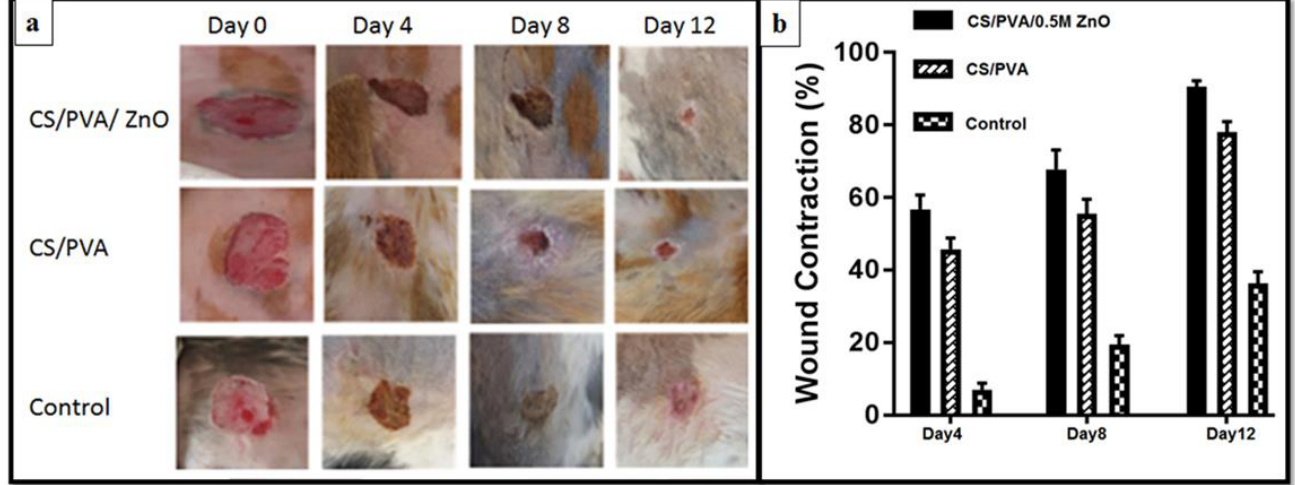
Figure 10. ( a ) The wound healing time of diabetic rabbits treated with control, CS/PVA, and CS/PVA/ZnO nanofiber mats over a 12-day period. ( b ) A chart illustrating 12 days of wound contraction [195].